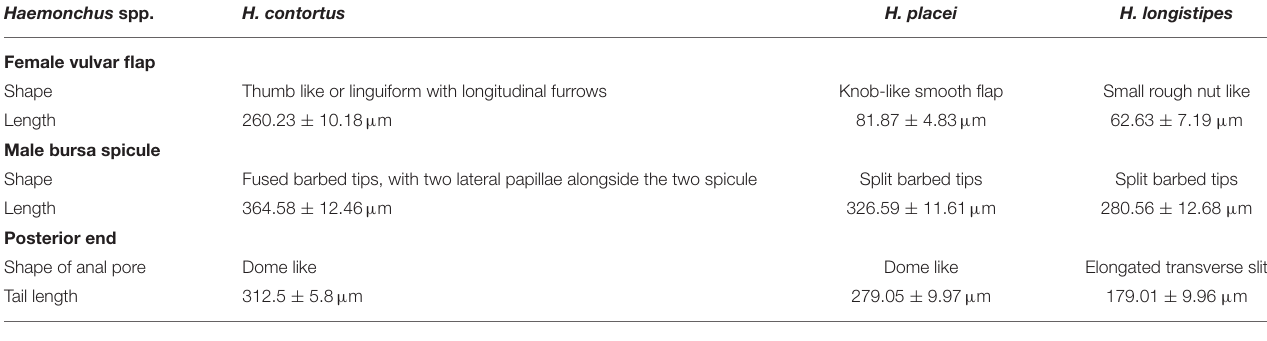
TABLE 2 | Morphometric measurements of the Haemonchus spp. recovered. Haemonchus spp.